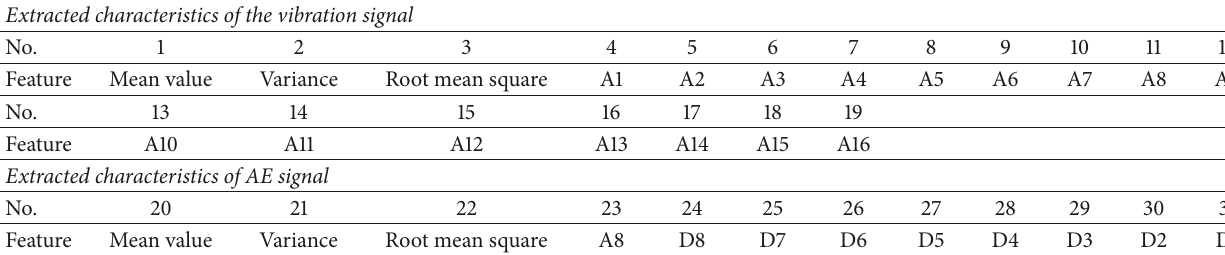
Figure 18: The average weight of the classification ability of each feature. Table 8: A total of thirty-one extracted